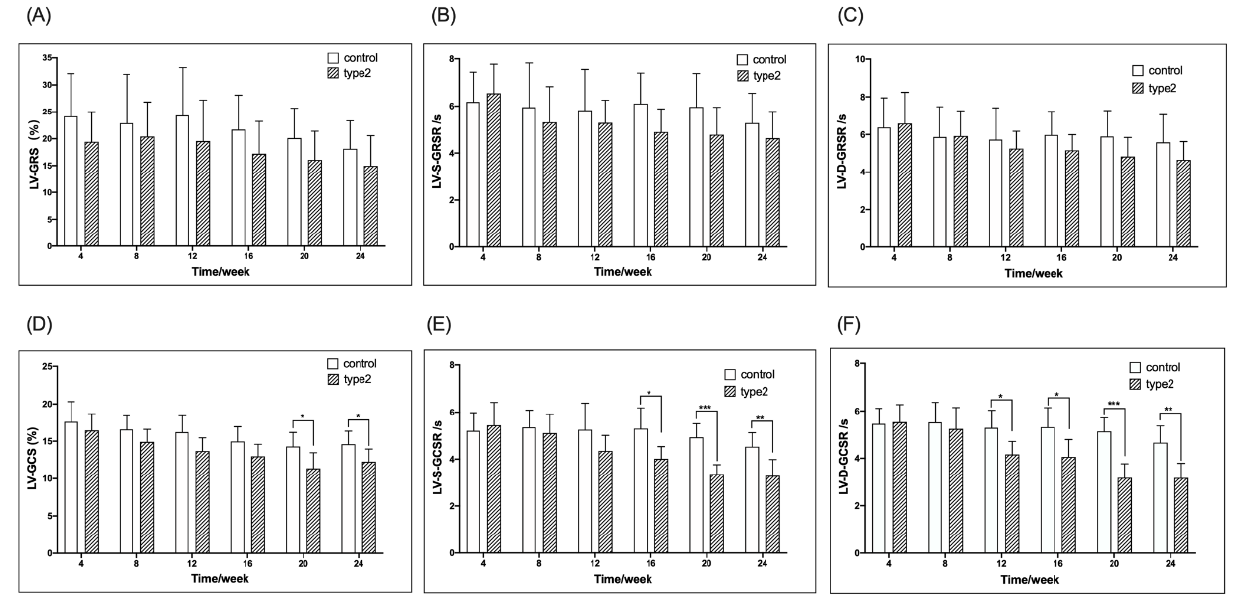
Figure 2. Timely/weekly comparison of the LV-GRS, LV-S-GRSR, LV-D-GRSR and LV-GCS, LV-S- GCSR, LV-D-GCSR between the T2DM mice and controls ( A – F ). LV-GRS, left ventricular global radial strain rate; LV-S-GRSR, left ventricular systolic global radial strain rate; LV-D-GRSR, left ven- tricular diastolic global radial strain rate. LV-GCS, left ventricular global circumferential strain rate; LV-S-GCSR, left ventricular systolic global circumferential strain rate; LV-D-GCSR, left ventricular diastolic global circumferential strain rate. T2DM: type 2 diabetes, * p < 0.05, ** p < 0.01, *** p < 0.001.